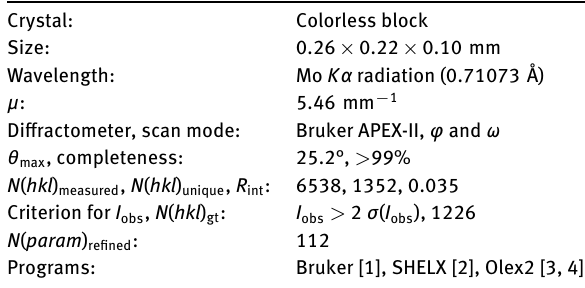
Table 1: Data collection and handling.